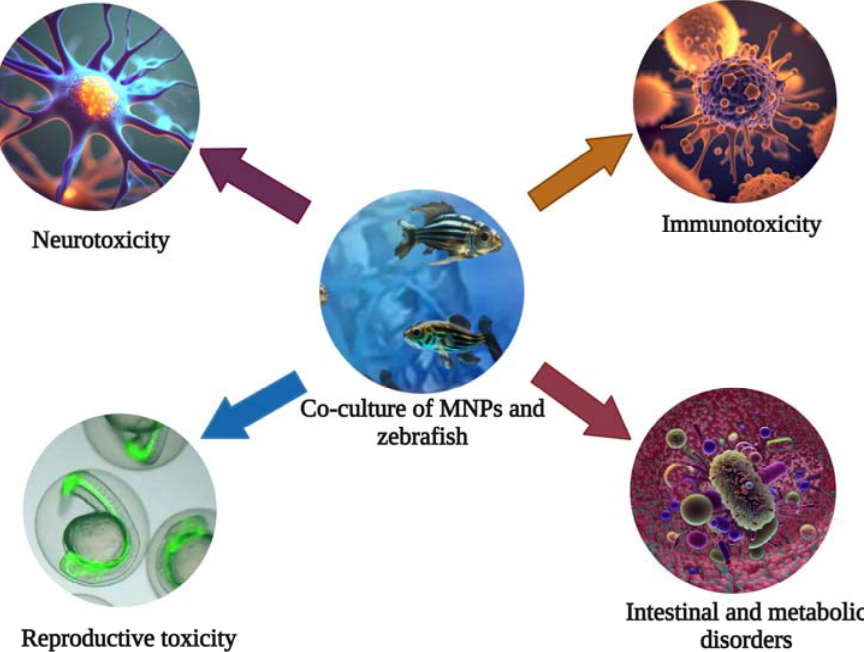
Figure 1. The zebrafish can be used for toxicity evaluation and mechanistic studies of the nervous, Figure 1. The zebra fi sh can be used for toxicity evaluation and mechanistic studies of the nervous, reproductive, and immune systems of MNPs. reproductive, and immune systems of